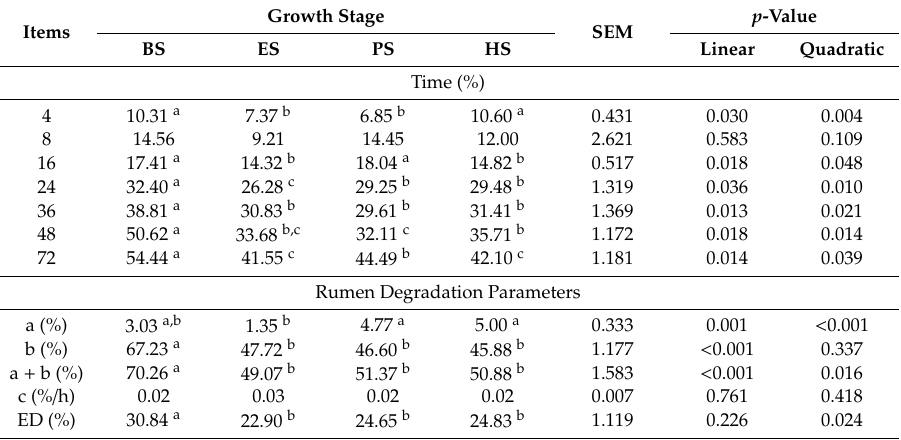
Table 5. Rumen degradability and degradation parameters of ADF of amaranth